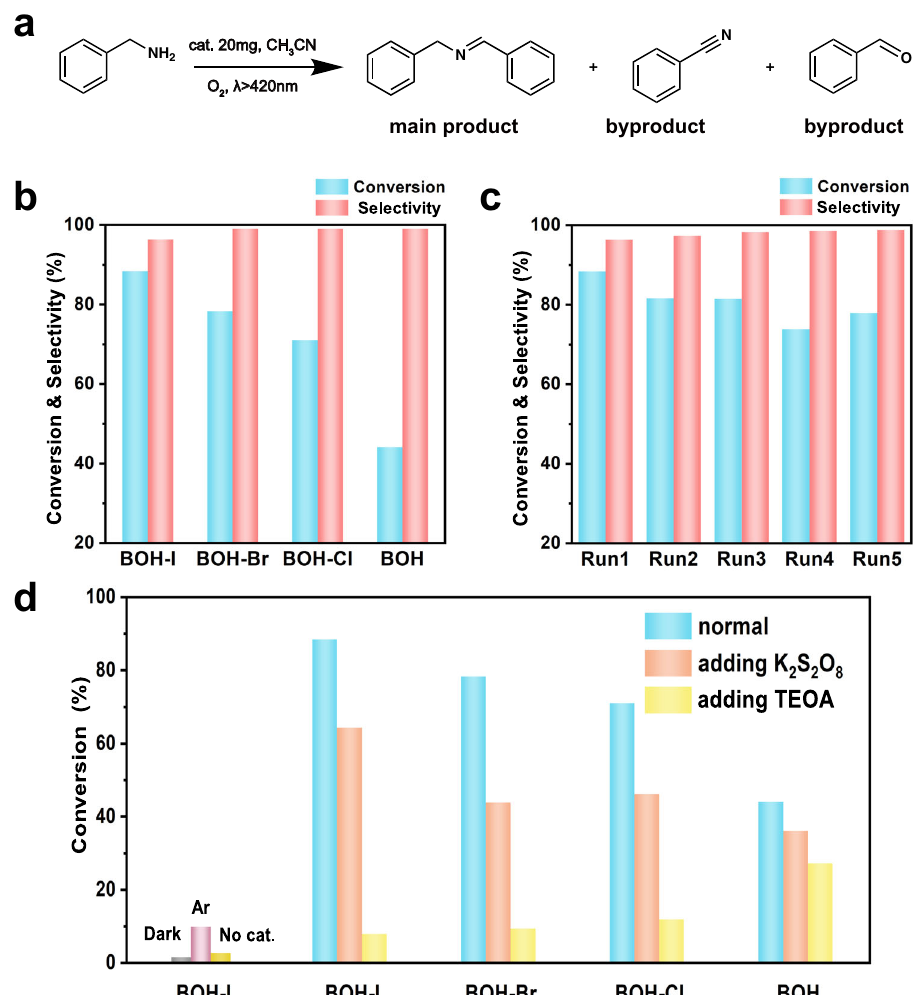
Fig. 5 Photocatalytic activity. a Equation of photocatalytic oxidative coupling of benzylamine. b Catalytic performances over BOH and BOH-X samples. c Results from recycle experiment on BOH-I. d Catalytic performances over BOH and BOH-X under normal conditions and with different scavenging agent, and the catalytic performances over BOH-I in dark or under Ar